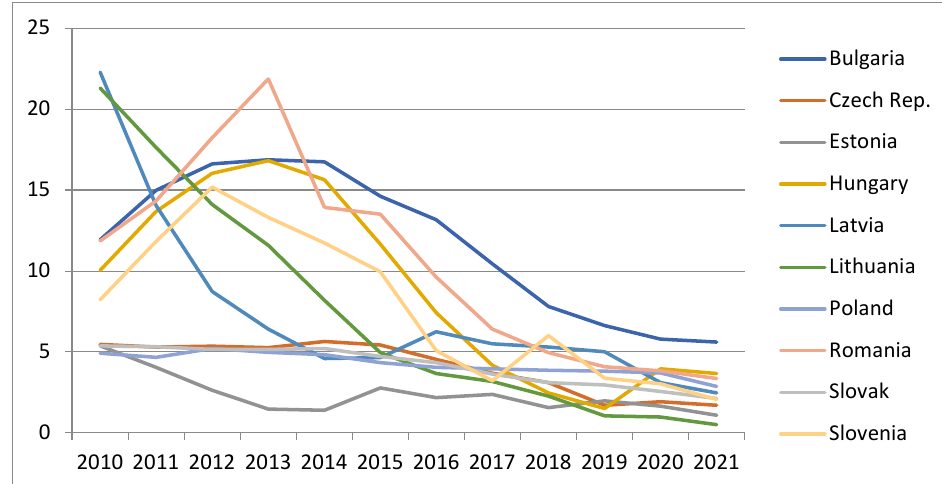
Figure 2. Non-performing loans to total gross loans, %.